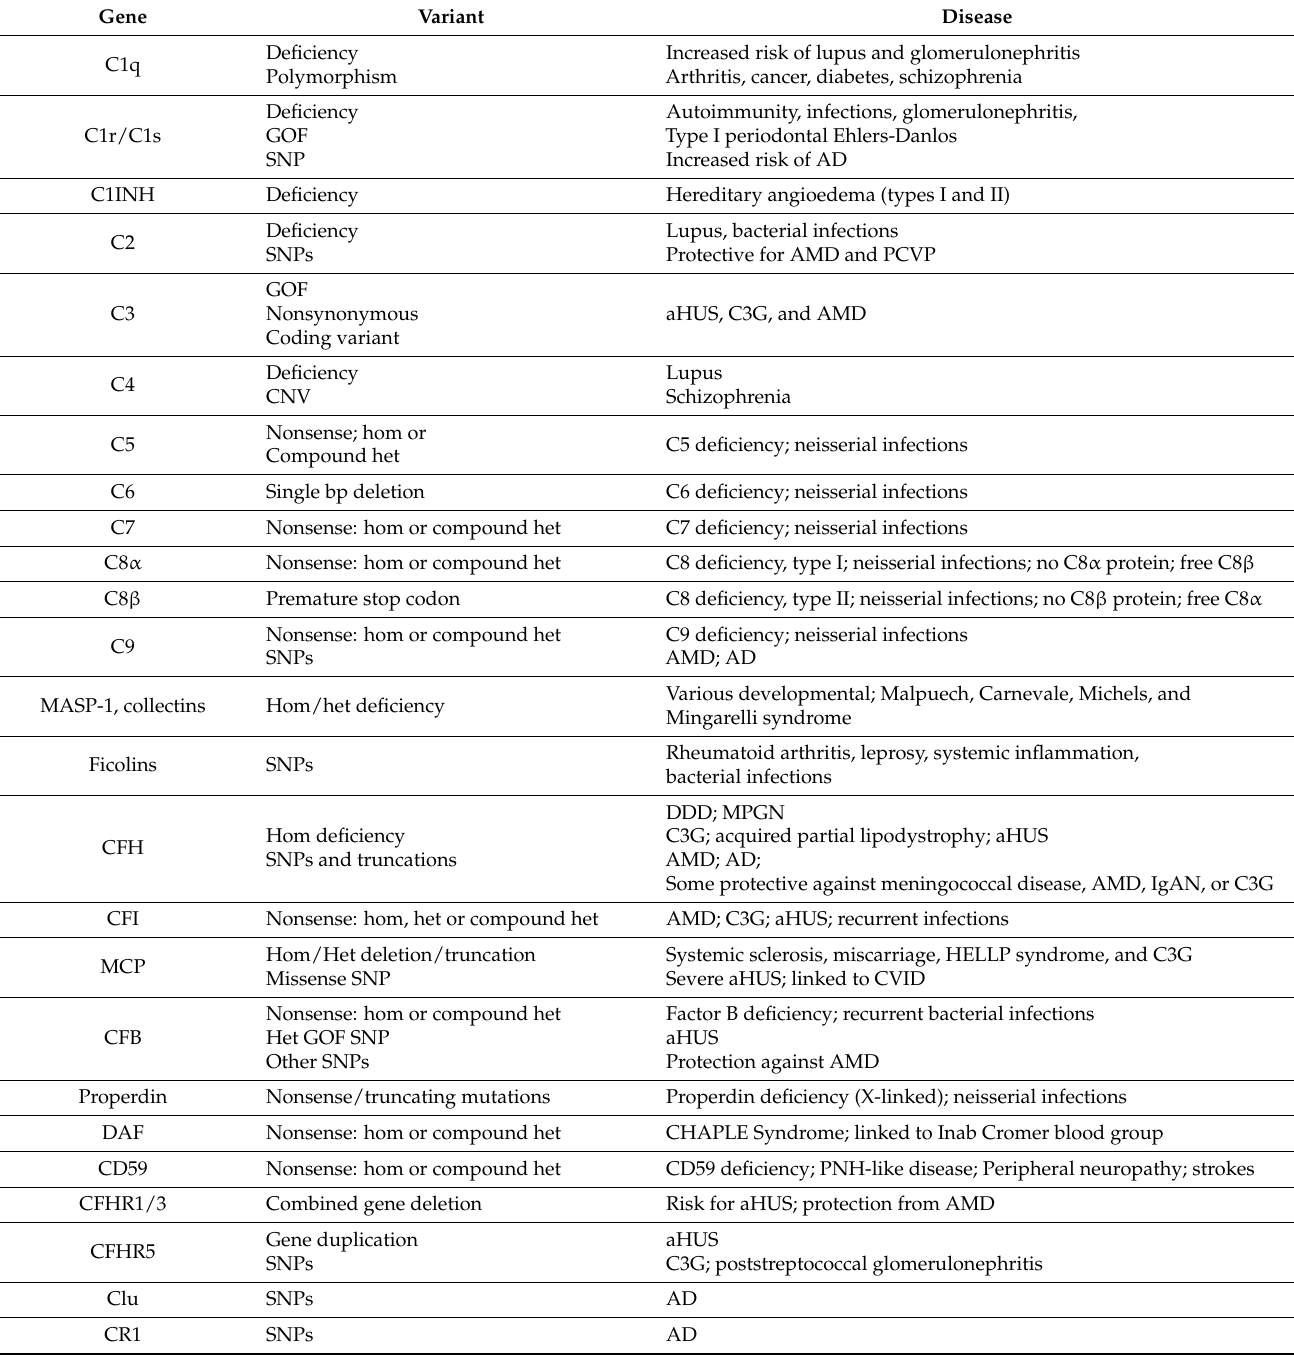
Table 1. Complement gene variants and associated